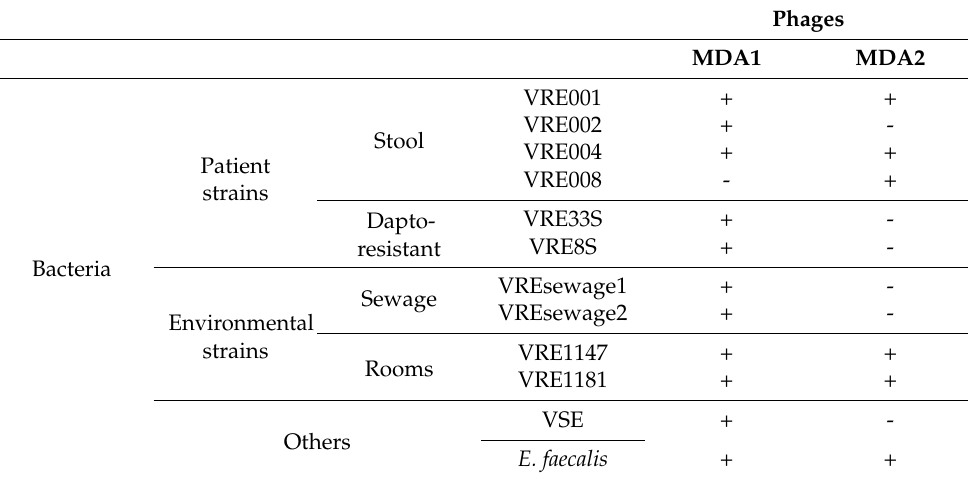
Table 1. Activity of phages against VRE fm isolated from different sources. Boxes with (+) to show the ability of the phage to lyse the VRE fm strain tested, (-) indicates that the phage had no effect on the tested bacteria.